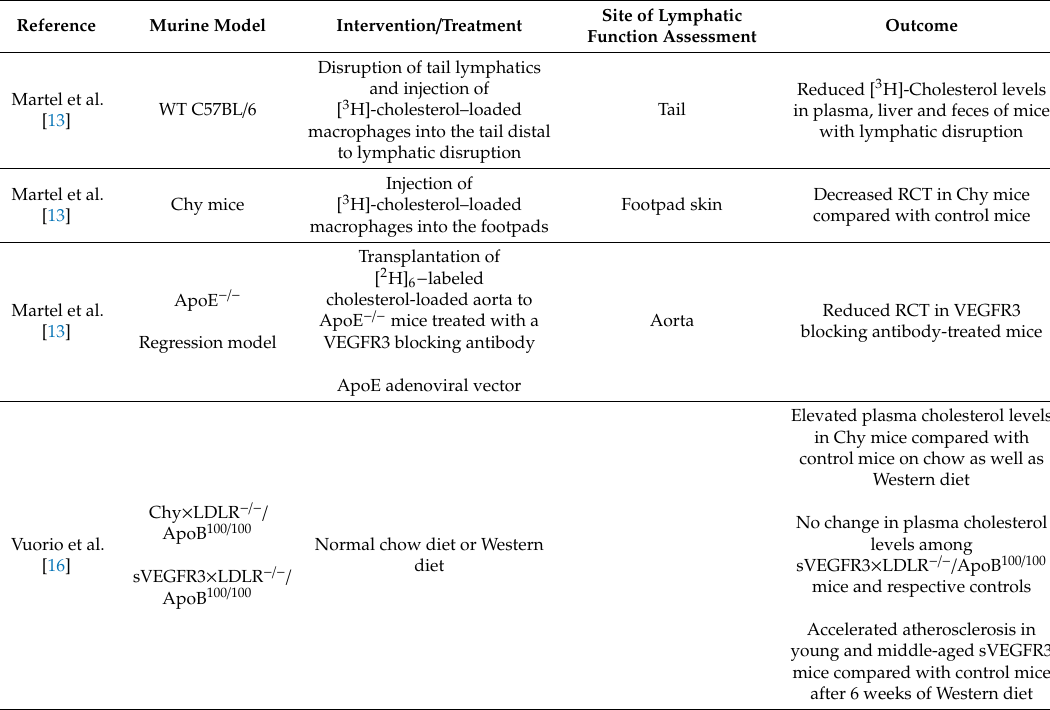
Table 1. Role of lymphatics in mRCT and immune cells tra ffi cking in the arterial